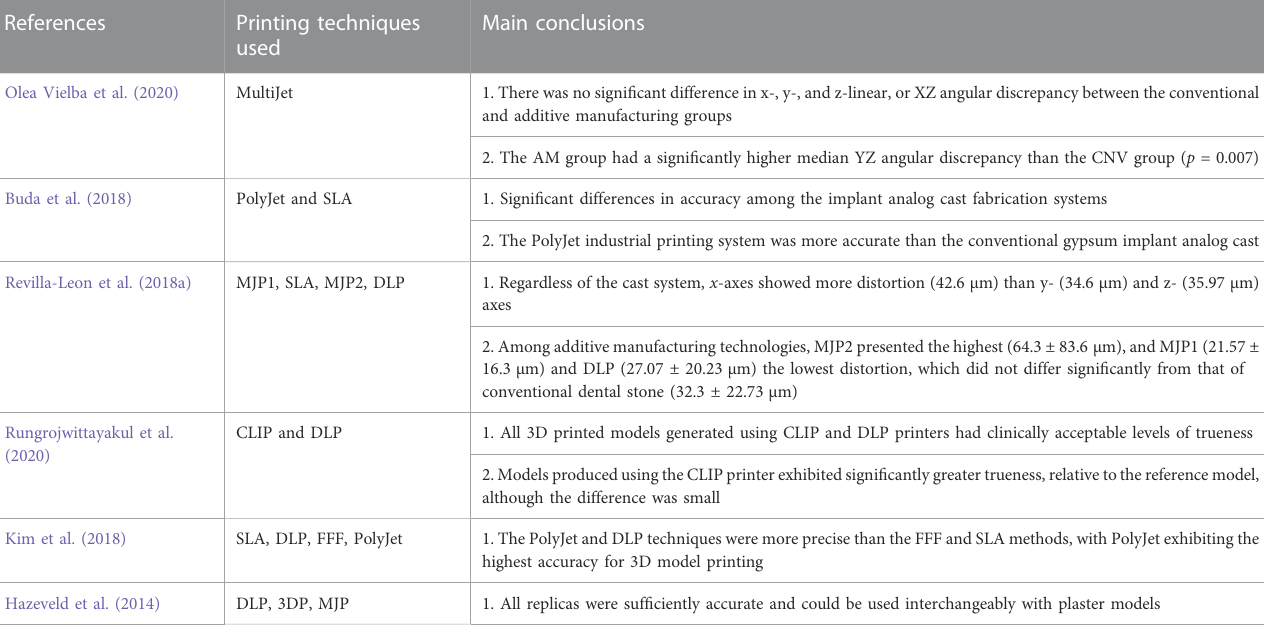
TABLE 4 Accuracy of different 3D printing techniques for fabrication of implant models for use in dental